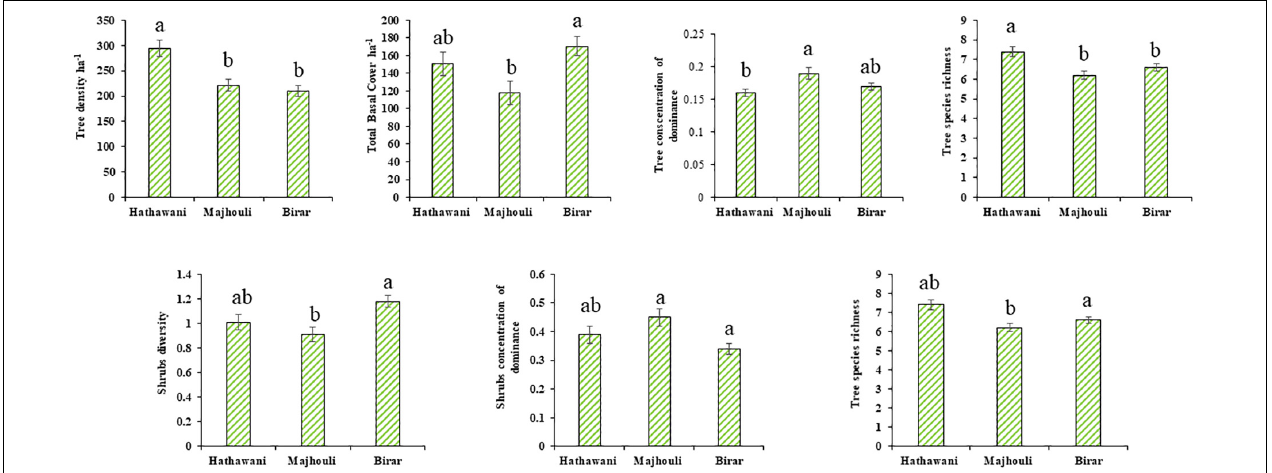
FIGURE 3 | The distribution of diversity parameters in home gardens at high (Birar), medium (Majhouli), and low (Hathawani) disturbance. All the values are means ± S.E. The data were compared on the basis of p -values ( p ≤ 0.05; 95% confidence level) by using one-way ANOVA. Different letters indicate significant differences in different disturbances as analyzed by Tukey’s HSD